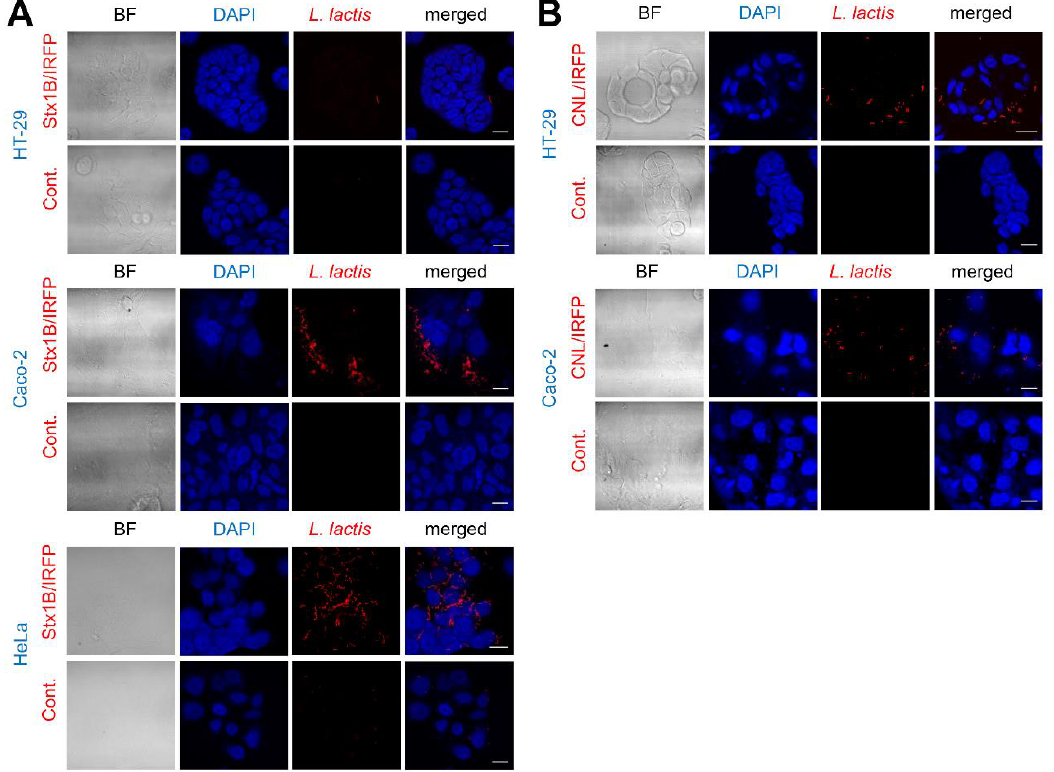
Figure 7. Representative confocal microscopy images showing binding of Shiga holotoxin subunit B (Stx1B)-displaying L. lactis to HeLa, HT-29, and Caco-2 cells ( A ) and Clitocybe nebularis lectin (CNL)-displaying L. lactis to HT-29 and Caco-2 cells ( B ). Cont.: control L. lactis expressing infrared fluorescent protein (IRFP); BF: bright field. Scale bars: 20 µ